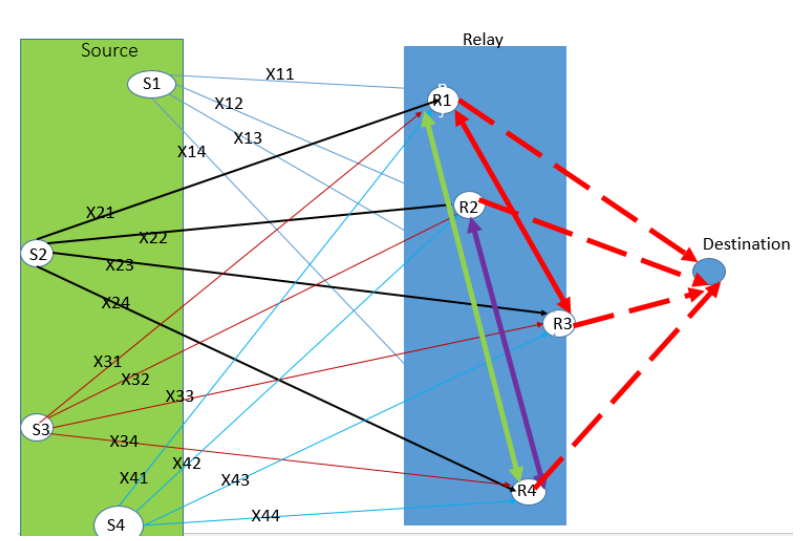
Figure 2. Two and three hop optimization network